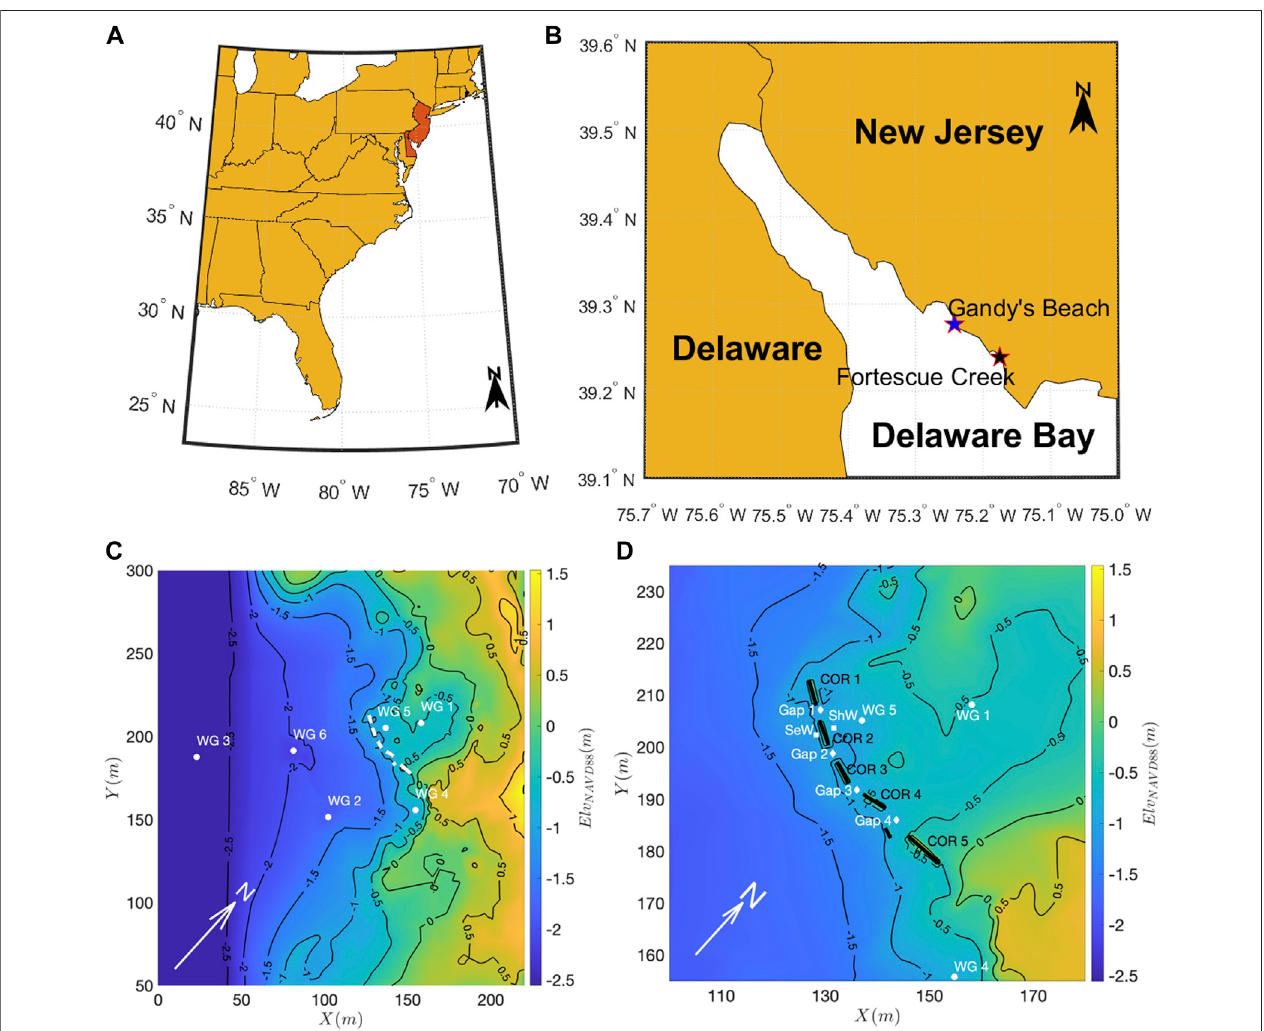
FIGURE1|(A) MapshowingthelocationofDelawareBaybetweenNewJerseyandDelawareintheUnitedStates, (B) mapshowingthelocationofGandysBeach and the Fortescue Creek station in Delaware Bay, (C) topography of Gandys Beach (NAVD88) and location of six wave gauges, and (D) detailed view of the CORs in Gandys Beach. CORs are named COR 1 to COR 5 from the uppermost COR downward. Six additional numerical wave gauges are placed around the CORs including Gap1 – 4,SeW, and ShWinFUNWAVE-TVD. Gap1 toGap 4refer tothegaps betweenthe CORsegments,SeW isseawardofCOR2, and ShWisbehind COR 2.